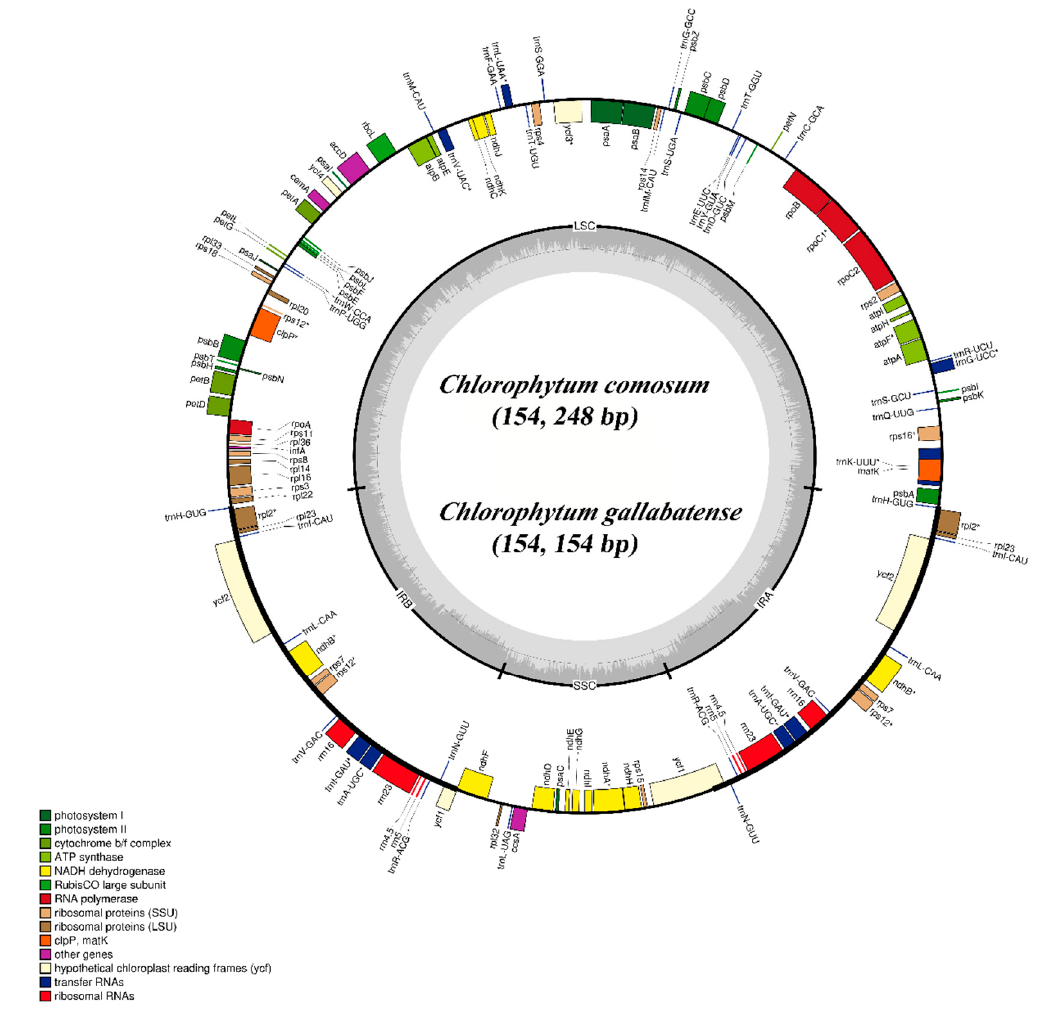
Figure 1. Gene map of the C. comosum and C. gallabatense complete cp genomes. Genes drawn within the circle are transcribed in the clockwise direction, and genes drawn out are transcribed in the counterclockwise direction. Genes are color-filled, basing on different functions. Inverted repeat (IR), small single-copy (SSC), and large single-copy (LSC) regions are indicated.